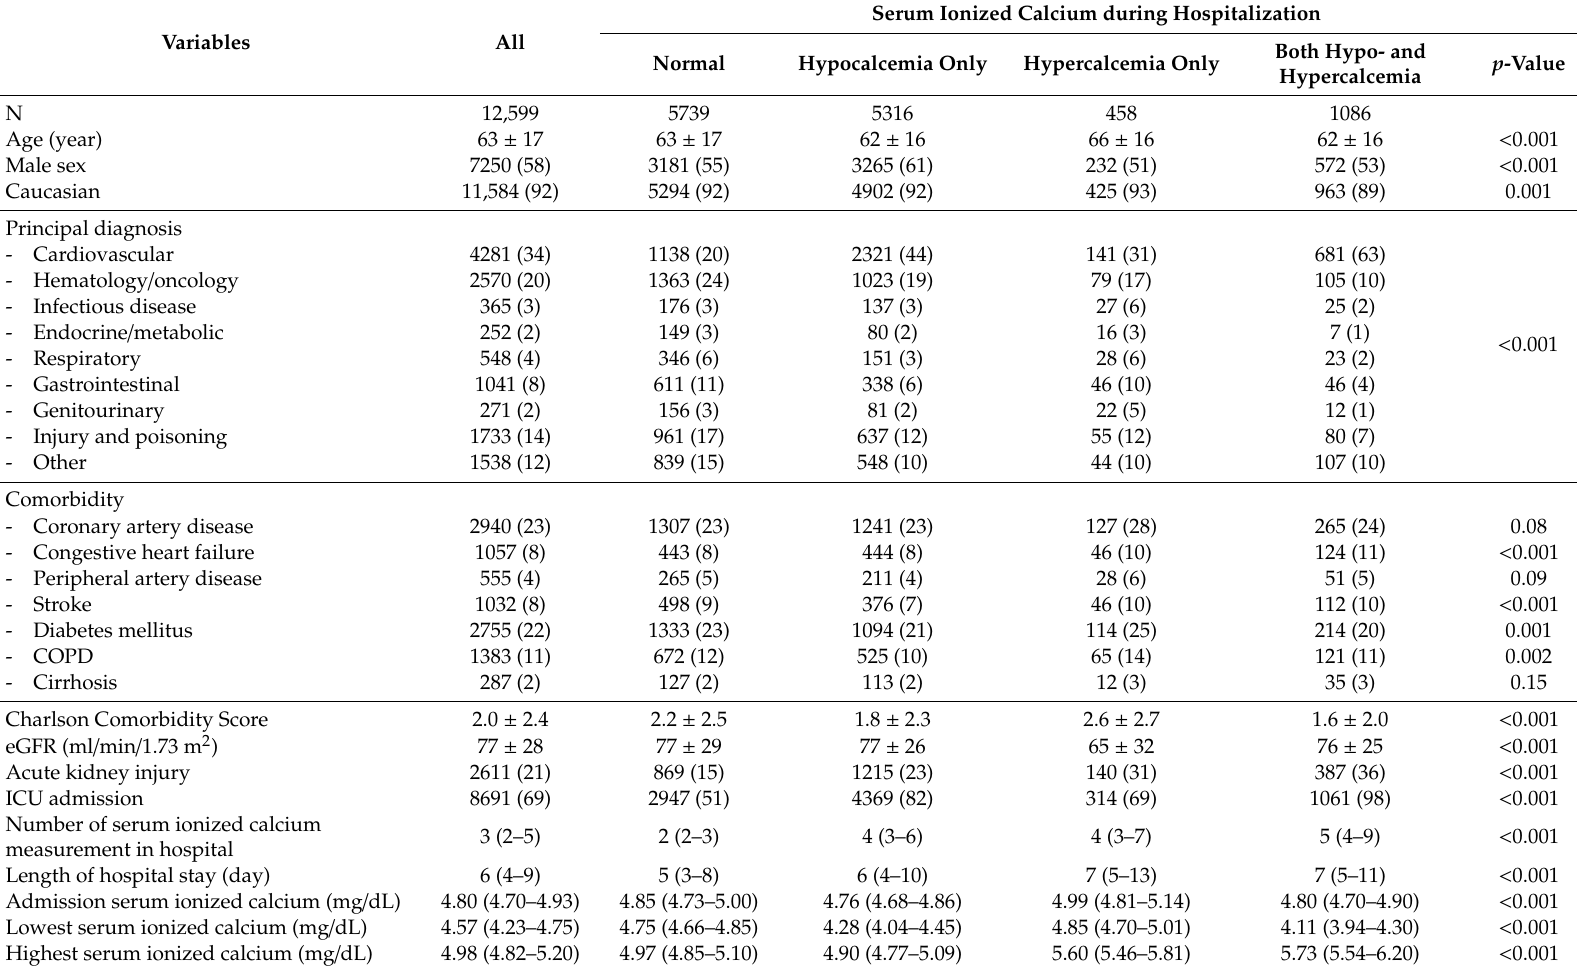
Table 1. Clinical characteristics of study